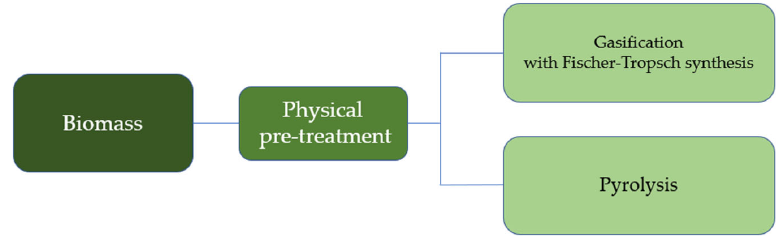
Figure 3. Classification of thermochemical methods.